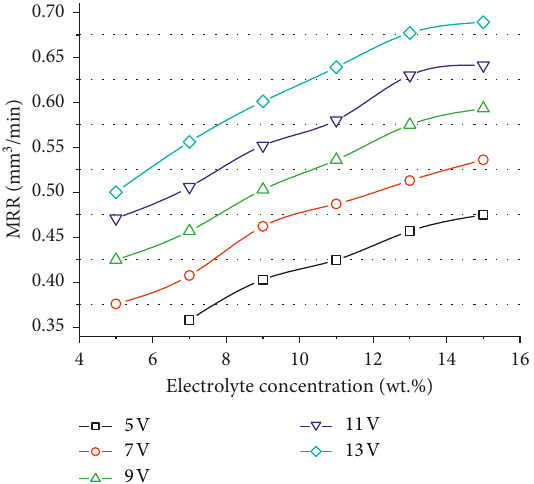
Figure 8: Variation curves of MRR with electrolyte concentration.